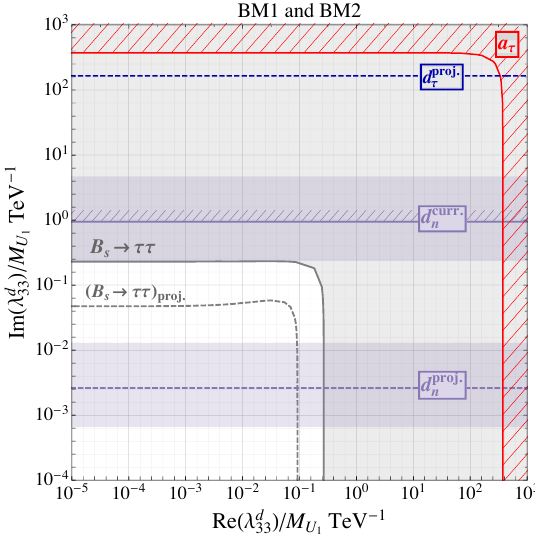
Figure 2 . Constraints on the U 1 leptoquark parameter space in the plane of the complex coupling (cid:21) d divided by the leptoquark mass, M U , and all other parameters (cid:12)xed as in BM1 (2.6a) or 33 1 BM2 (2.6b). The gray region enclosed by the solid gray curve represents parameter space that is excluded by B s ! (cid:28) + (cid:28) (cid:0) , while the dashed gray curve is the projected sensitivity of LHCb to B s ! (cid:28) + (cid:28) (cid:0) . The red hatched region is excluded by the bound on the tau lepton